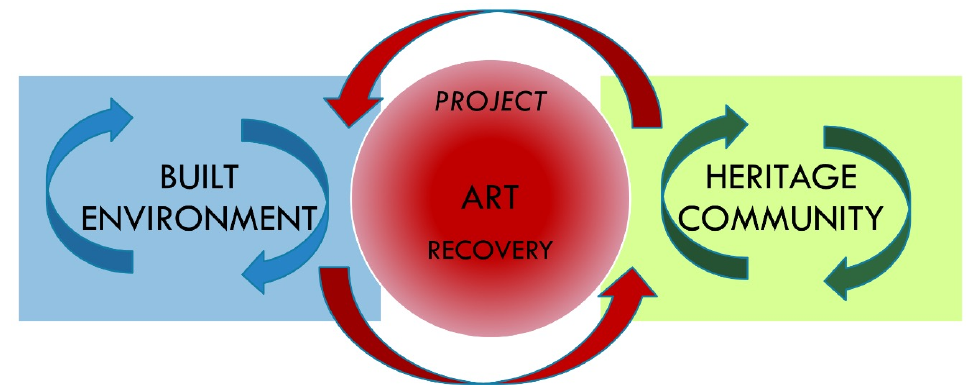
Figure 1: The contribution of art in reactiving the systemic functioning of landscape (Picture: Anna